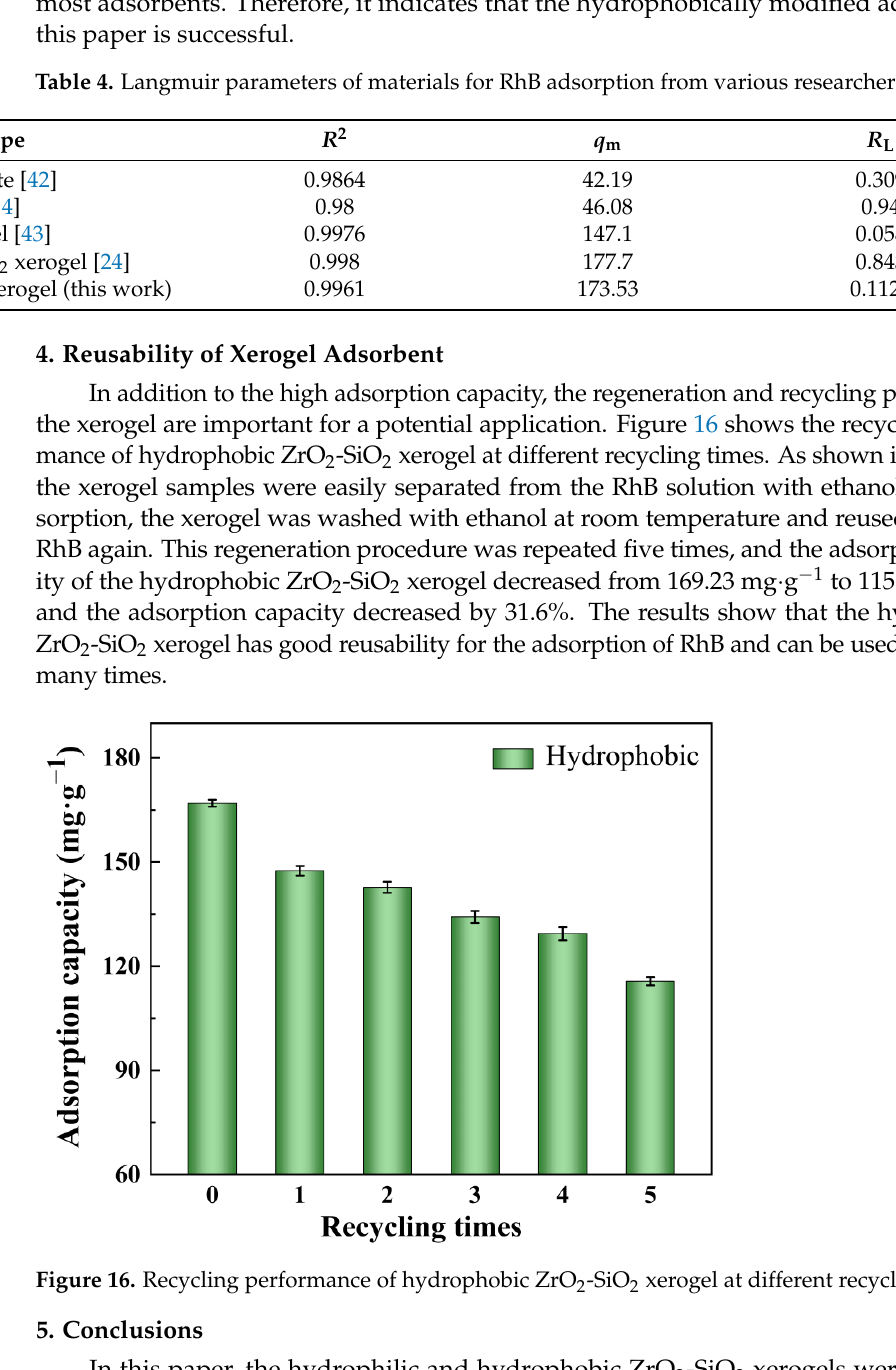
2 -SiO 2 xerogel at different recycling